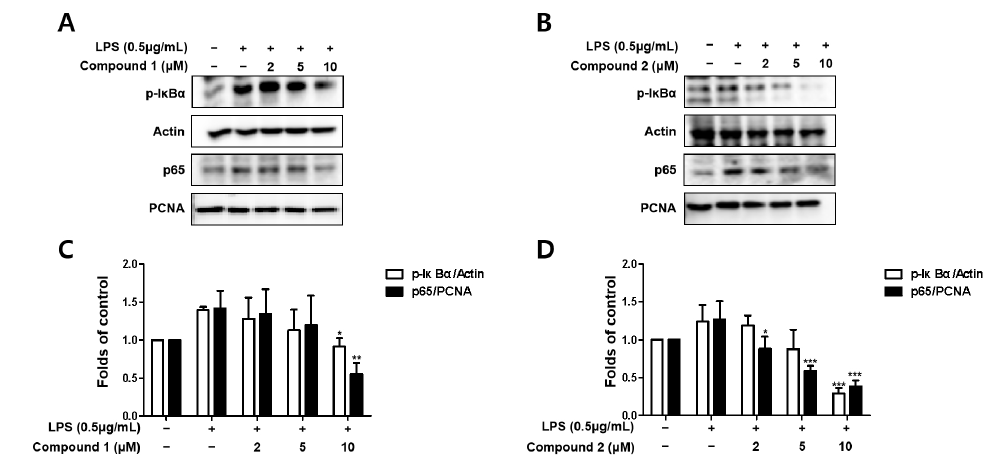
Figure 5. Effects of the isolated compounds on the NF- κ B (p65) pathway in BV2 cells ( A – D ). Cells were pretreated with indicated concentrations of compounds 1 and 2 for 3 h and stimulated with lipopolysaccharide (LPS, 1 µ g/mL) for 1 h. Representative blots from three independent experiments are shown. Immunoblots were quantified using ImageJ software. p-I κ B α intensities were normalized to β -actin. P65 intensities were normalized to PCNA. * p < 0.05, ** p < 0.01, *** p < 0.001 compared with LPS-treated group.